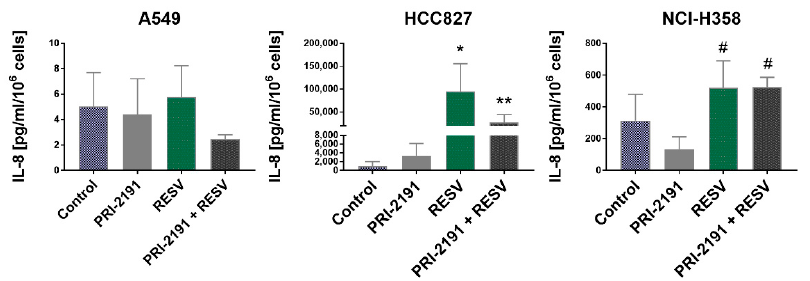
Figure 7. Effect of PRI-2191 and RESV on osteopontin (OPN) secretion by lung cancer cells. RESV was used at a concentration of 20 µM and PRI-2191 at 100 nM. Cells were exposed to tested compounds for 72 h, then washed with PBS, and cultured in a serum-free medium for the next 24 h. Conditioned medium was collected, and the level of OPN secreted by lung cancer cells was measured by ELISA. * Compared to control; ** compared to control (untreated cells) and PRI-2191; *** compared to control, PRI-2191, and RESV ( p < 0.05, one-way ANOVA with Tukey’s post hoc with multiple comparisons).